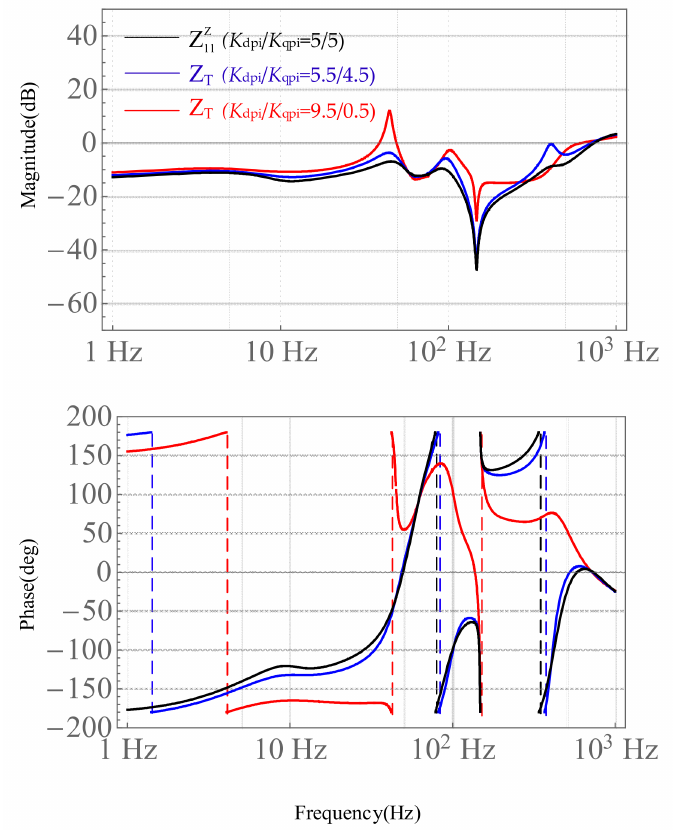
of the Bode diagram in the frequency domain and time-domain HIL simulations was used to determine the system’s stability. The RT-Lab experimental platform set-up is shown in Figure 8. It consists of three parts: (1) the Host computer installed with MATLAB/Simulink (R2011b), (2) OPAL-RT Lab simulator including the OP5600 module and RT-Lab workbench (v10.7.0.361), and (3) DFIG controller hardware contains the TMS320F28335PGFA DSP digital controller, DC bus capacitor, an oscilloscope and etc.